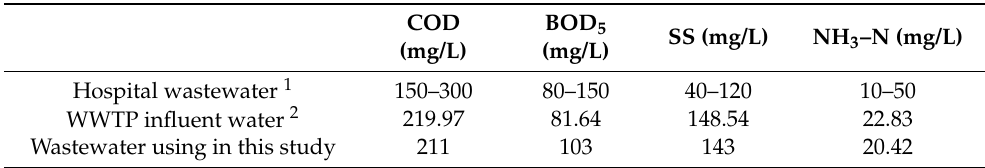
Table 2. Comparison of hospital wastewater, WWTP influent water, and the wastewater quality used in this